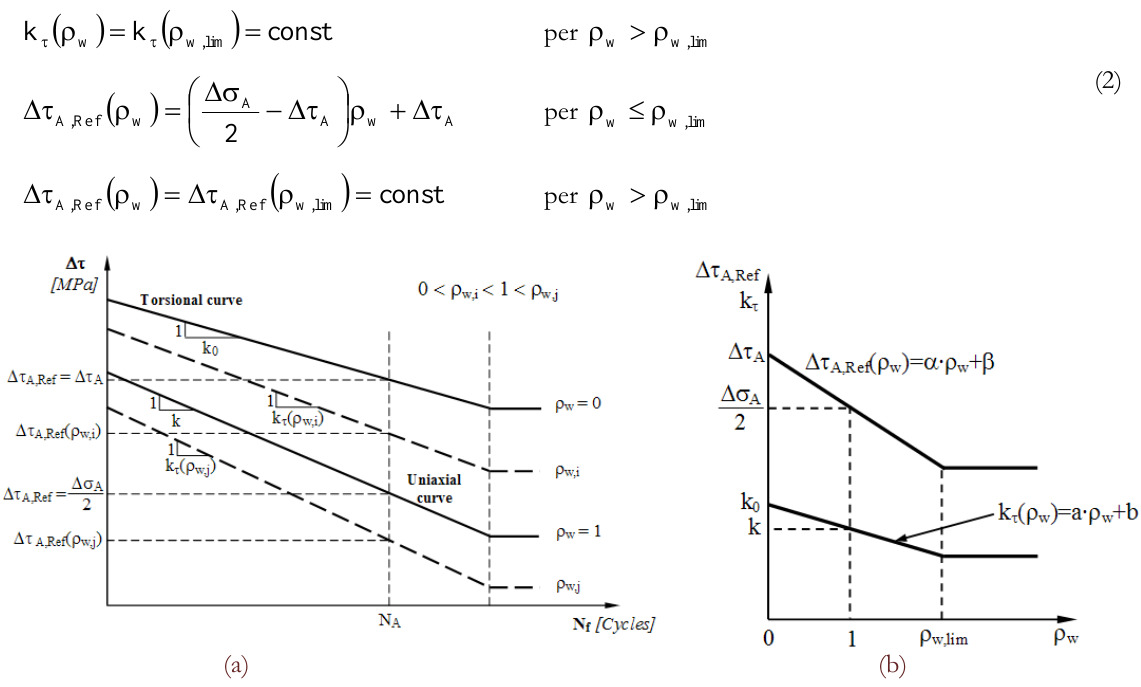
Figura 1: (a) Diagramma di Wöhler modificato e (b) andamento di  A,Ref e k τ con ρ w